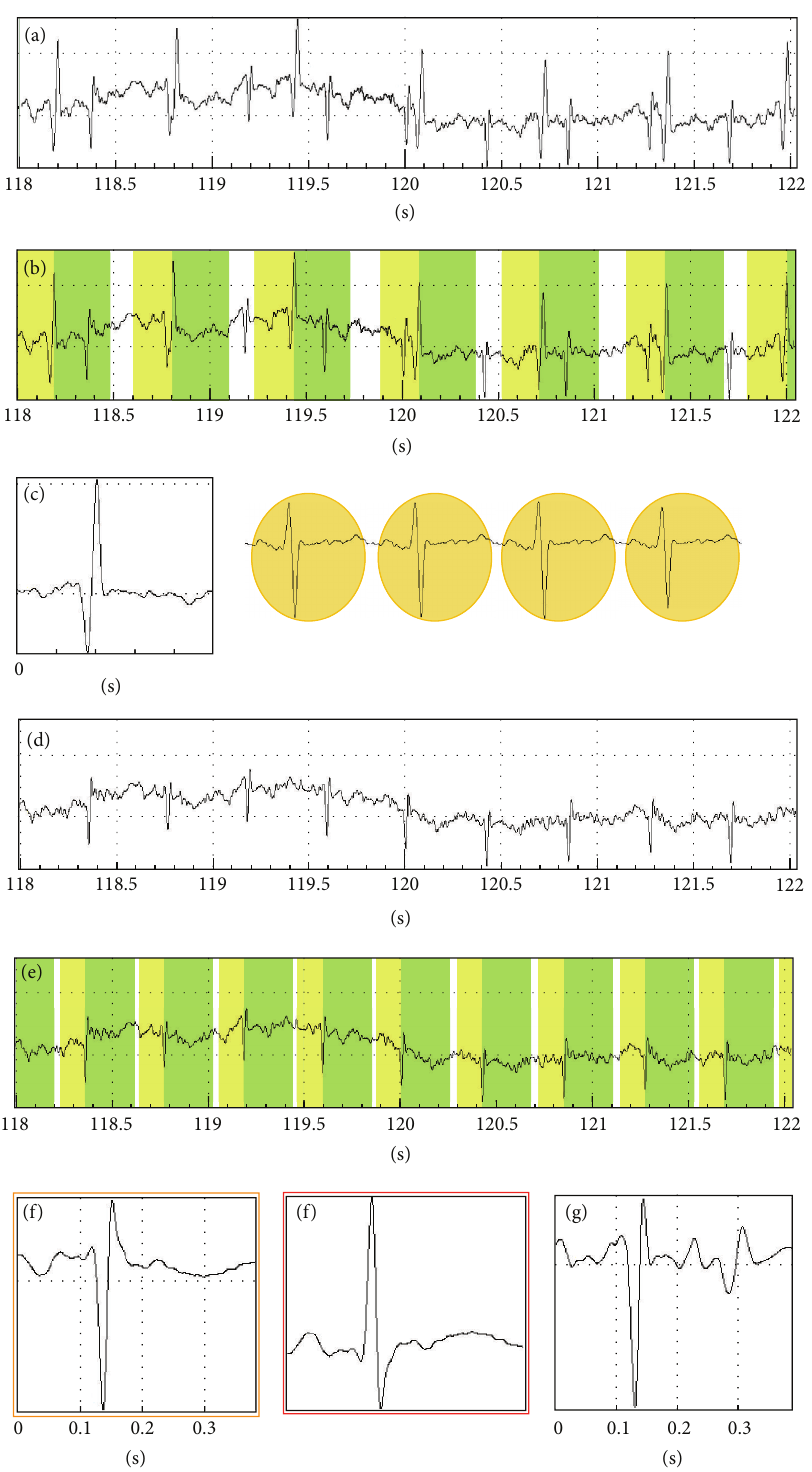
Figure 2: (a) Transabdominal record at the 39th week of pregnancy. The fetal ECG R wave is quite visible. (b) The software automatically identifies the maternal ECG R waves. (c) The system calculates the average of 30 maternal cardiac cycles. Then the computer extracts in real time the averaged signal from each identified maternal ECG heart event. (d) The “cleaned” abdominal signal, maternal waves are removed. (e) Using the same peak detection algorithm the fetal ECG R waves are identified. (f) After averaging 40 fetal heart events true-to-form fetal ECG is received. (g) It is very important to remove maternal waves, because otherwise the averaged fetal ECG cannot be